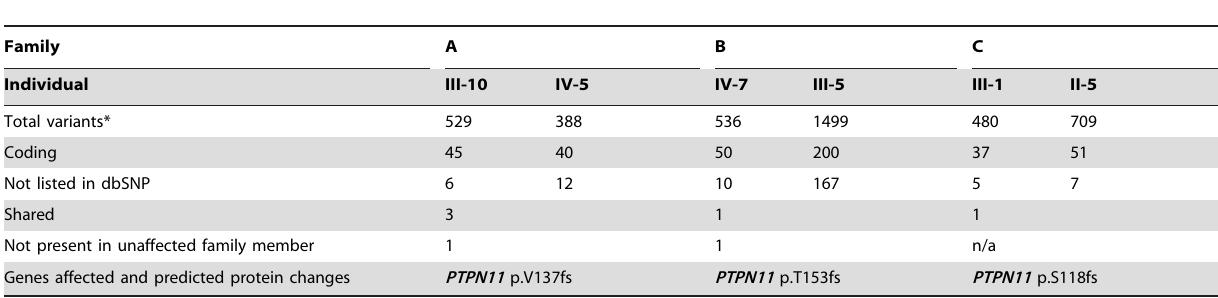
Table 1. Novel coding variants identified in three metachondromatosis